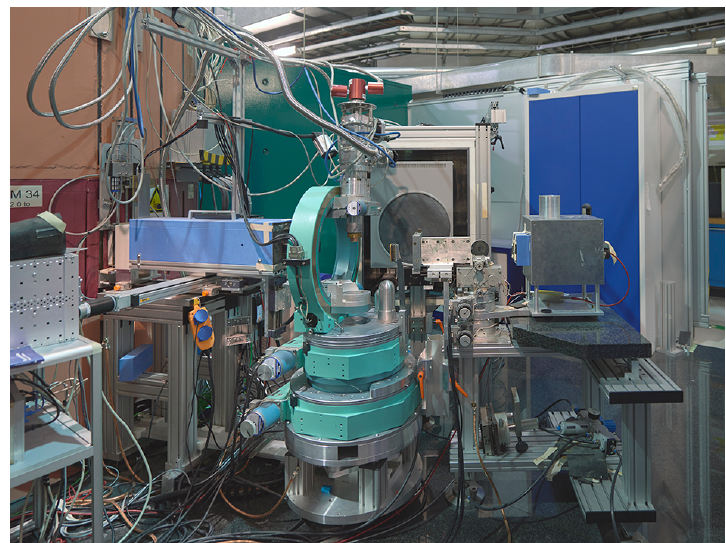
Figure 1: Instrument RESI with focusing guide (left), Eulerian cradle (middle, front), area detector (mid- dle, back) and single counter (right); (Copyright by W. Schürmann,